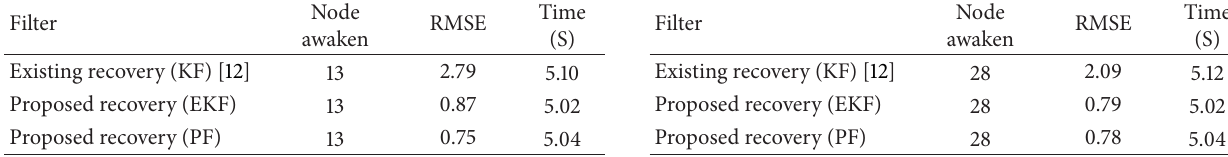
Table 5: Performance comparison: communication failure—Case II